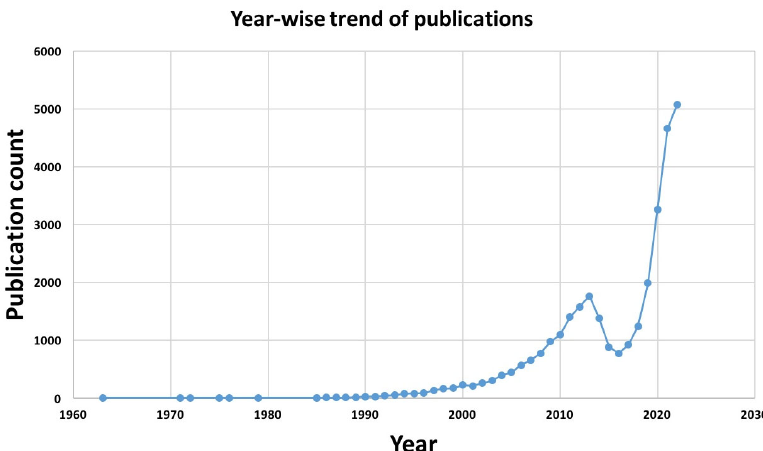
Figure 1. Cumulation of studies on AI in surgery during recent years in PubMed.